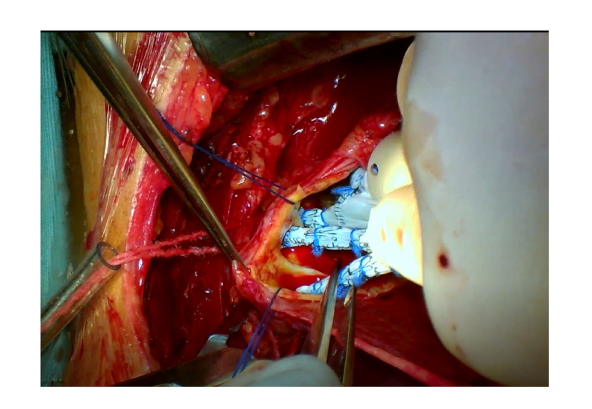
FIGURE 5 Partial upper sternotomy incision for total arch repair of acute type A aortic dissection.